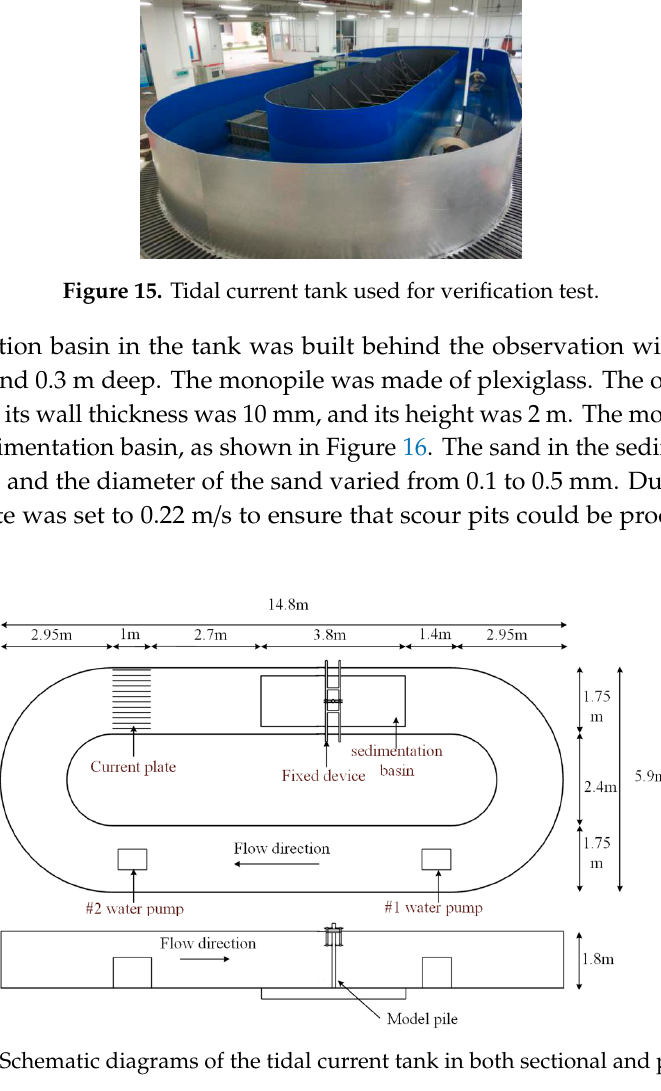
Figure 16. Schematic diagrams of the tidal current tank in both sectional and plan views.